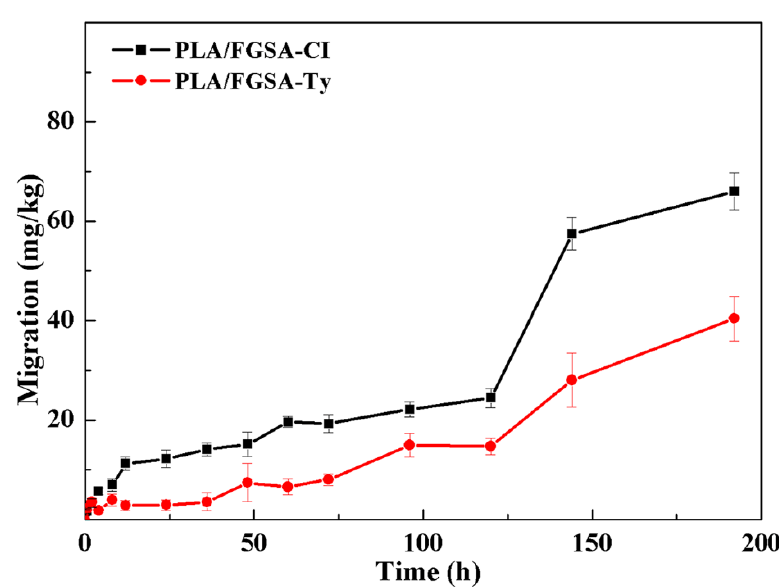
Figure 4. Release of CI and Ty from obtained active bilayer films (PLA/FGSA-CI and PLA/FGSA-Ty) into solid dry food simulant: Tenax TA.